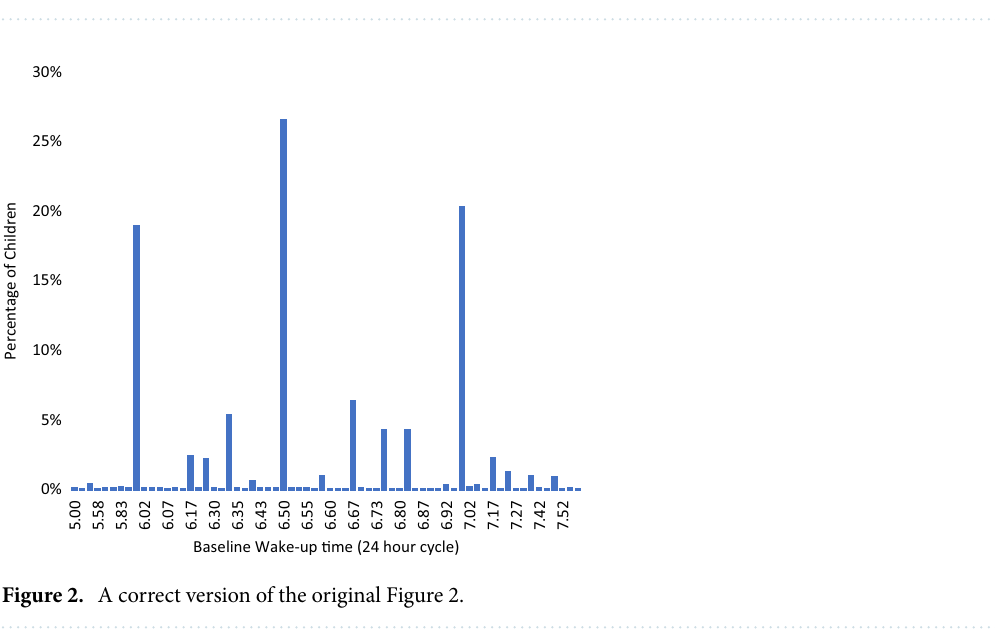
Figure 1. A correct version of the original Figure 1.